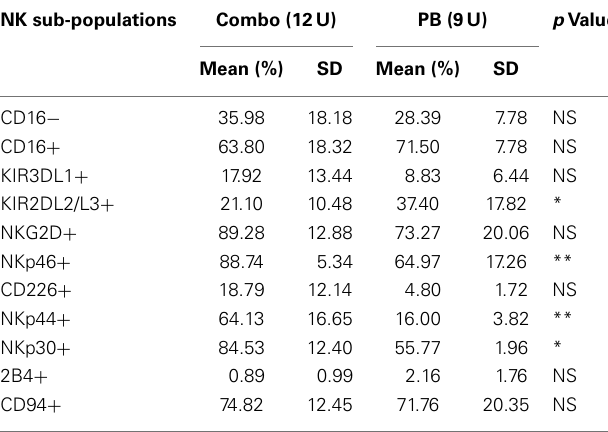
Table 9 | Sub-populations comparison in Day 21 expanded pNK versus Day 21 expanded PB NK.